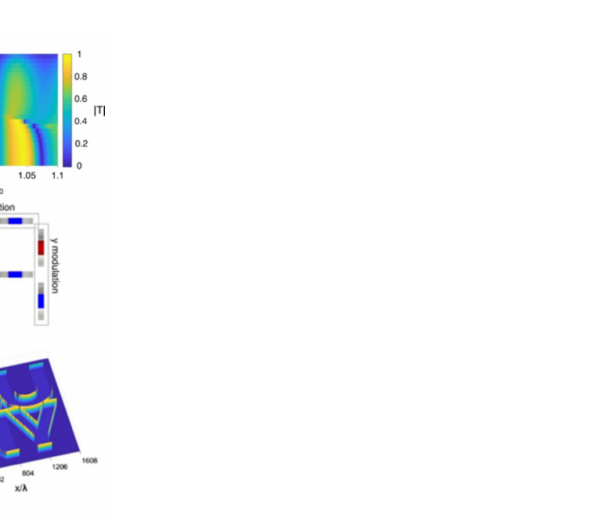
Figure 7. ( a ) Schematic of sinusoidally modulated of split-ring resonators; ( b ) transmission spectrum with different incident angle; ( c ) schematic of asymmetric metasurface with a horizontally misplaced array of metallic wires for the first-derivative operation; ( d ) rotated metasurface for 2D second- derivative operation. ( e ) Input image and ( f ) output image of 2D edge detection for linear polarized wave. Adapted with permission from [144], APS, 2018.